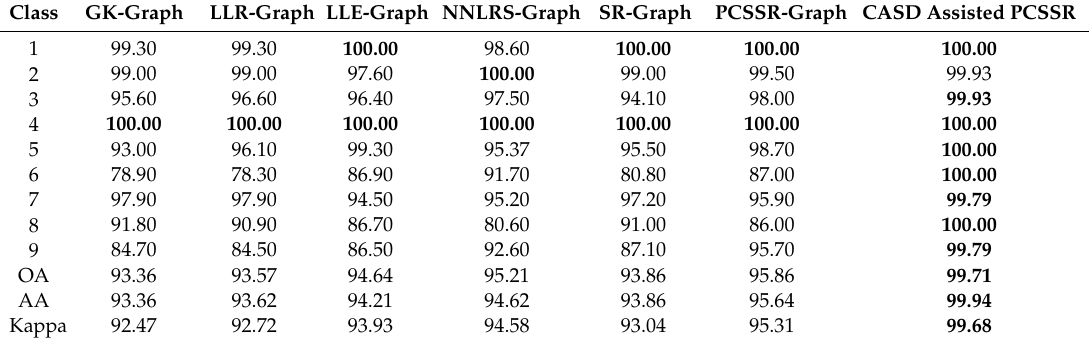
Table 3. Classification accuracy of each class, OA, average accuracy (AA) and Kappa coe ffi cients for BOT data with nine classes (20 training samples for each class). The highest value of each row is shown in bold.